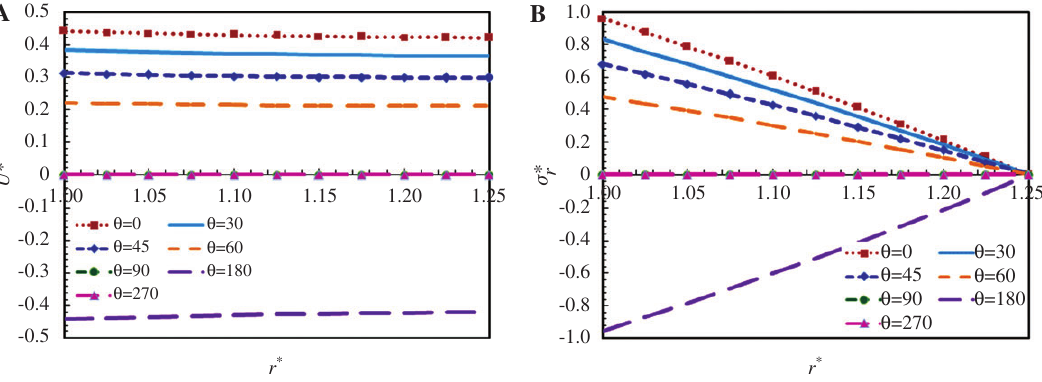
Figure 4 Through-thickness variations of non-dimensional (A) radial displacement and (B) radial stress component at the cylinder mid- length and t * = 1 for different angles θ .